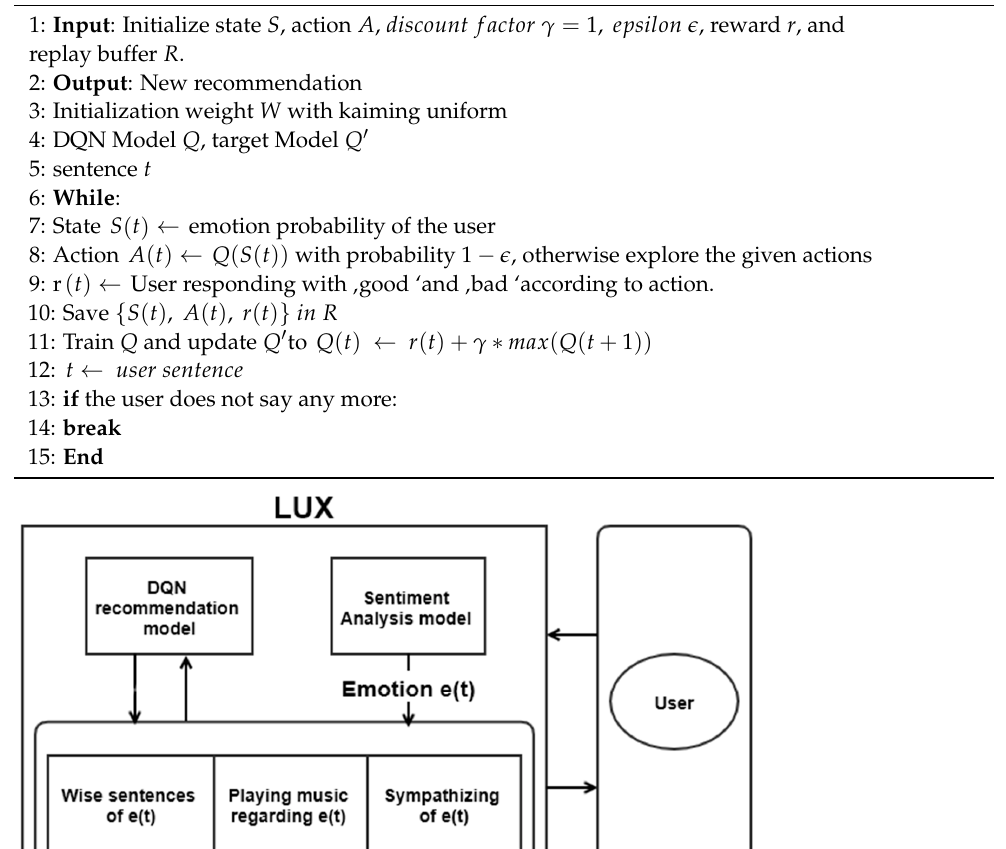
Algorithm 1 DQN algorithm to recommend user responses after sentiment analysis.